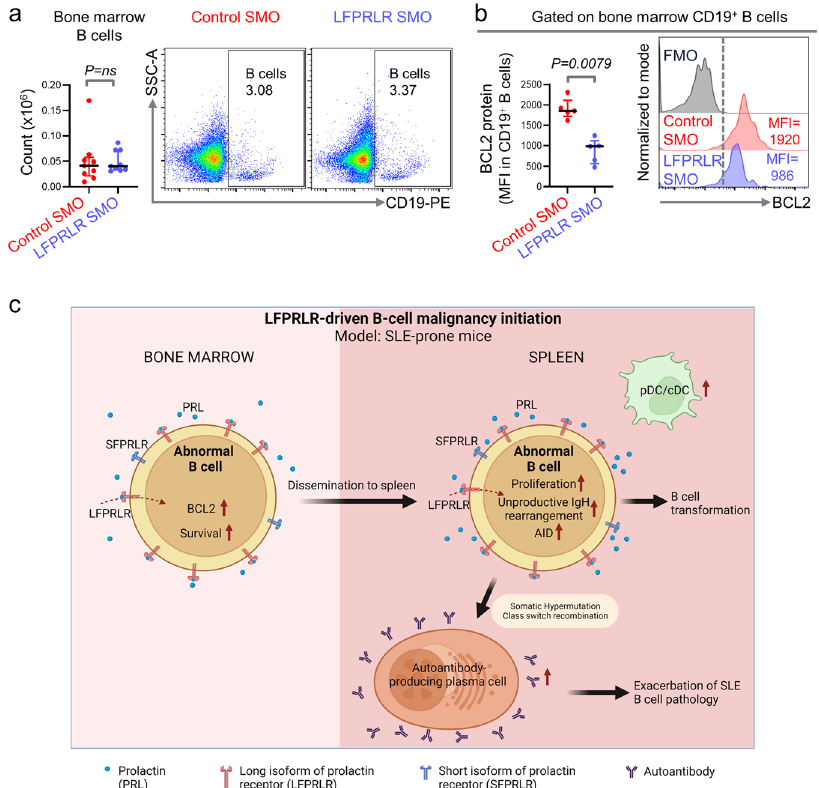
Fig. 3 Knockdown of LFPRLR impacts early B-lymphopoiesis in SLE-prone mice. a Quantitation and representative fl ow cytometry plots of bone marrow CD19 + B cells in MRL-lpr mice treated with control SMO ( n = 9, red) or LFPRLR SMO ( n = 9, blue). b Quantitation and representative histograms showing median fl uorescence intensity (MFI) of BCL2 protein in bone marrow B cells of control SMO-treated ( n = 5, red) and LFPRLR SMO-treated ( n = 5, blue) MRL-lpr mice by fl ow cytometry. c A model depicting the mechanisms by which LFPRLR increases the number of abnormal splenic B cells available for potential malignant transformation or the concurrent worsening of autoimmune pathology in SLE-prone mice. Graphs show median ± interquartile range. Exact p -values were calculated using the Mann – Whitney U test. ns non-signi fi cant, FMO fl uorescence minus one control. c was created with